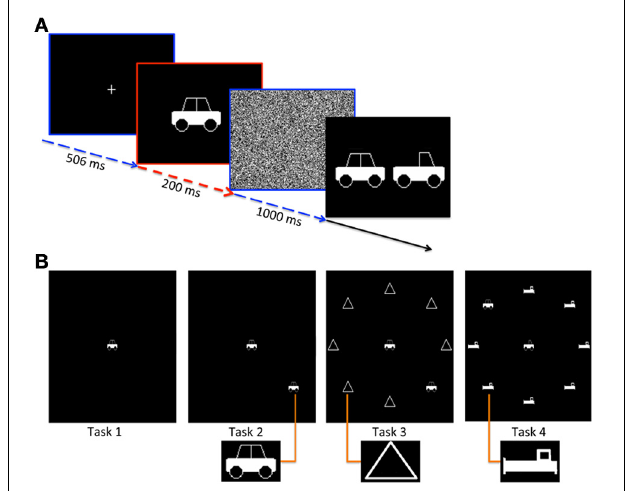
FIGURE 1 | (A) Task timing for each trial of the test. A fixation cross was presented for 506ms followed by the presentation of the stimulus for 200ms. Then a white noise mask was presented for 1000ms followed by a memory probe. (B) Different task levels. Stimulus screen is shown for each of the 4 tasks. Task 1 includes a central stimulus with no peripheral stimuli. Task 2 includes the central stimulus plus a peripheral stimulus with no distractors. Task 3 adds triangle distractors and Task 4 includes distractors that appear more similar to the stimulus. Popouts show zoomed in images of the peripheral